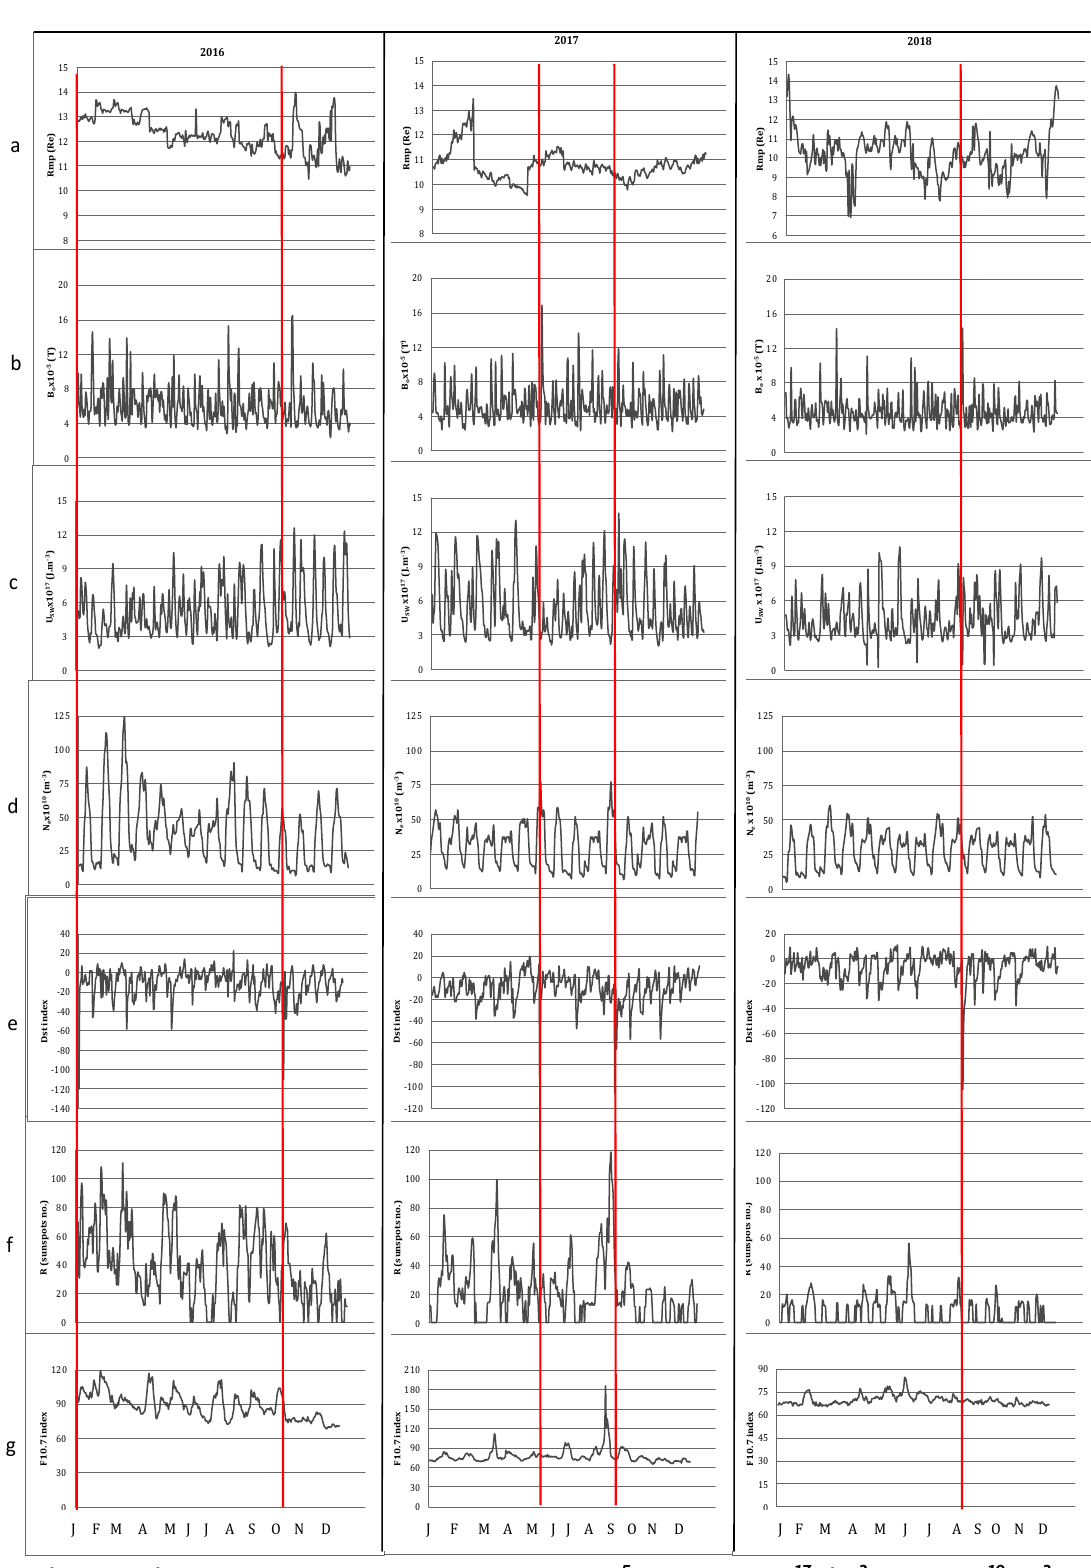
*R km , b) B x10 -5 T, c) U x10 17 j/m 3 , d) N mp e o SW